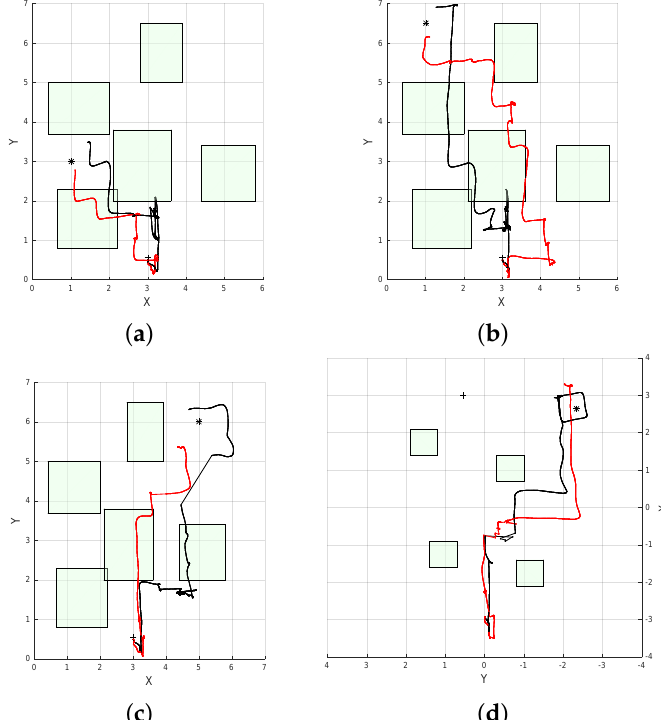
Figure 10. Example of trajectories to four different target locations produced by ABT (black) and POMCP (red) in simulation. ( a ) Target located at (1.0, 3.0, 0.15); ( b ) target located at (1.0, 6.5, 0.15); ( c ) target located at (5.0, 6.0, 0.15); ( d ) target located at (2.65, − 2.33,